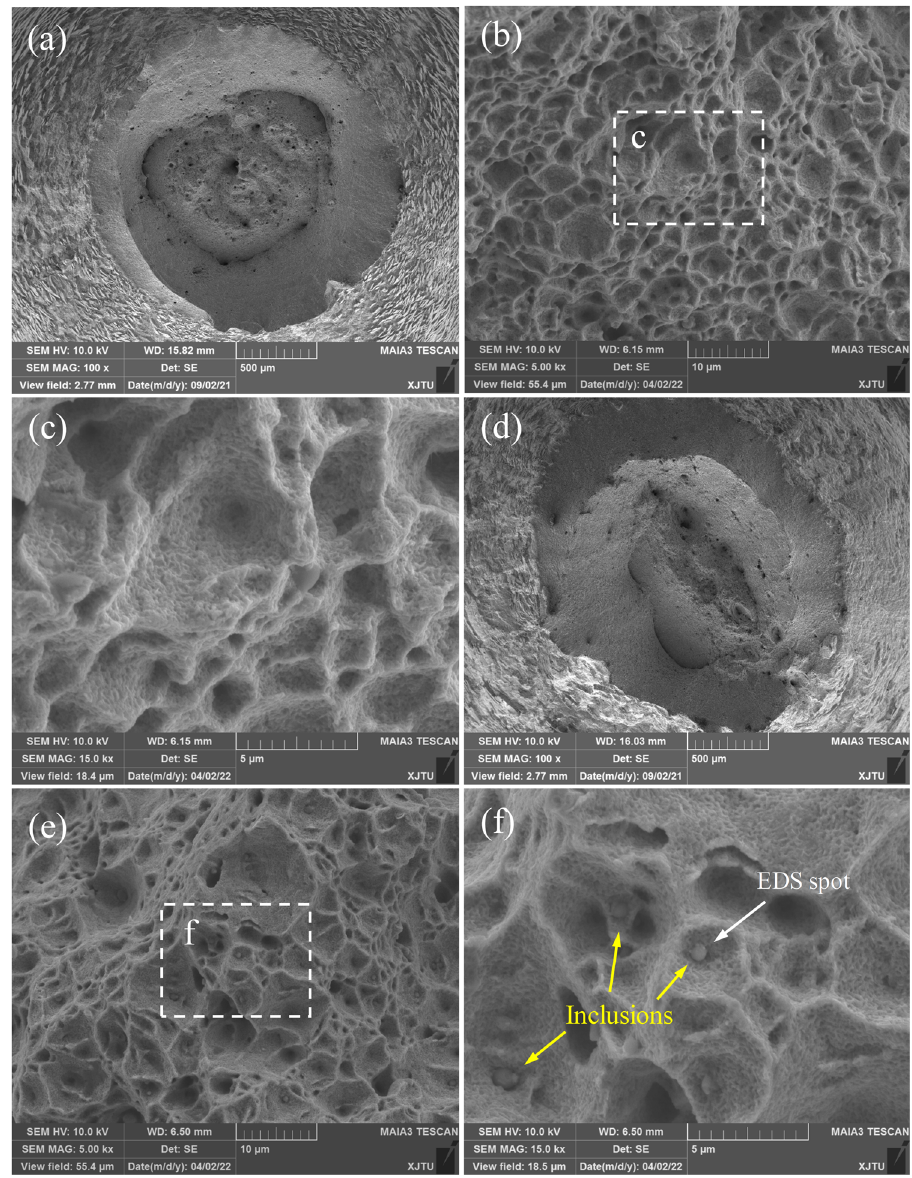
Figure 12: SEM fracture morphologies of the creep ruptured ( a – c ) BM and ( d – f ) WM specimens at 550°C under the stress of 275 MPa; ( c ) and ( f ) are the morphologies of dimples in ( b ) and ( e ) ,